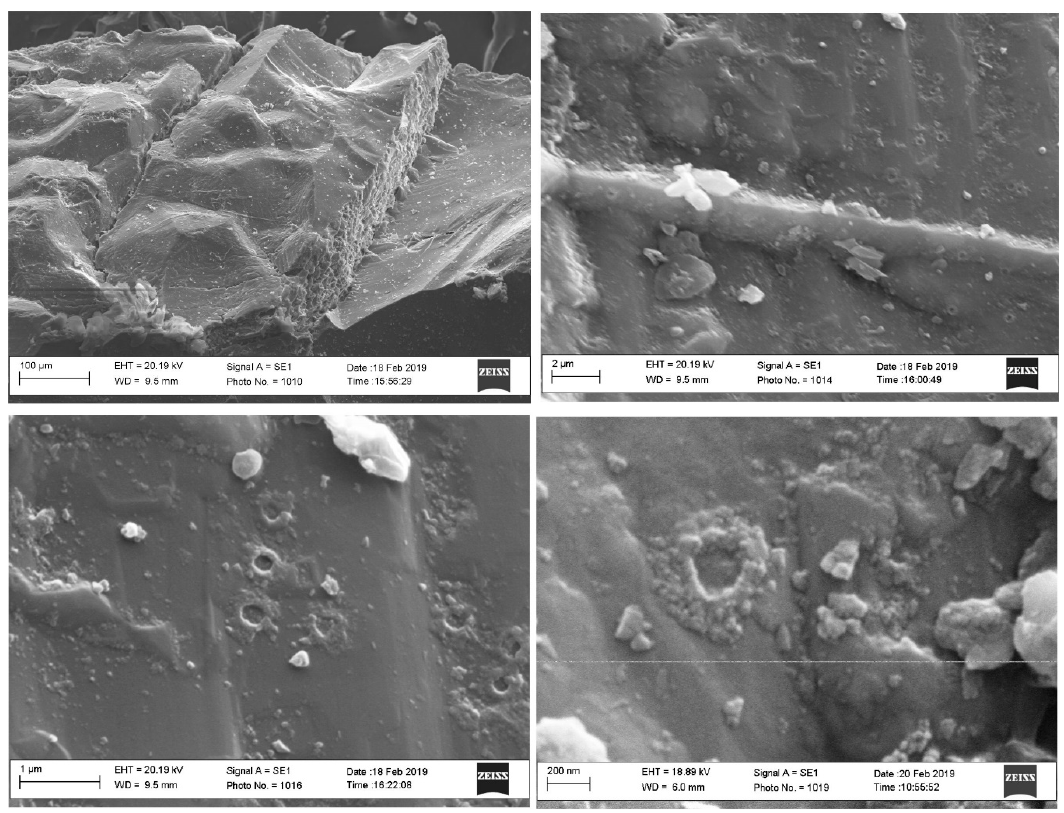
Figure 8. Quartz, 120 MPa: “hot spot” on quartz particle surfaces.